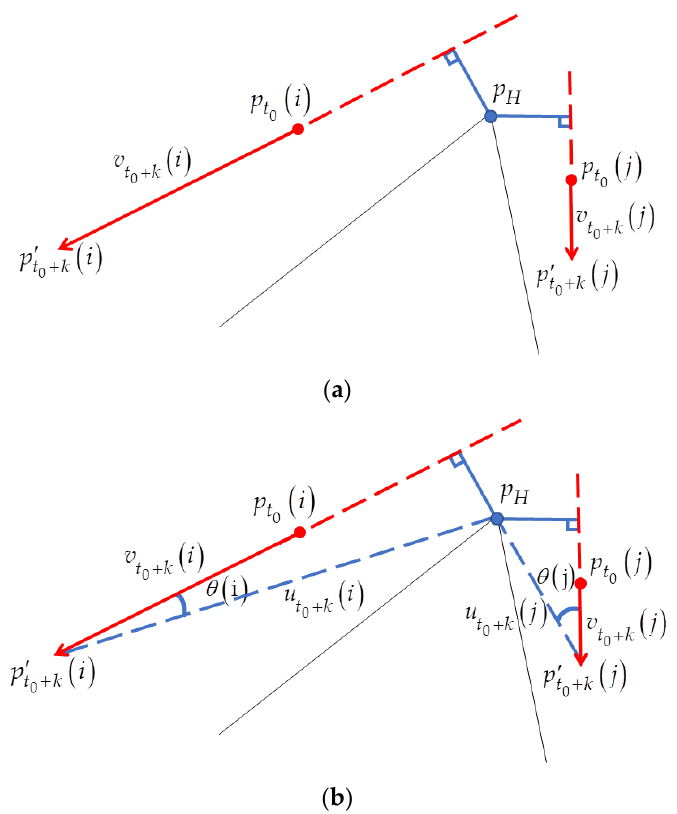
Figure 5. Examples of ( a ) perpendicular distance metric and ( b ) the proposed angle-based metric between vectors and hypothesis R-VP, assuming that hypothesis R-VP p H is obtained from randomly selected two vectors.